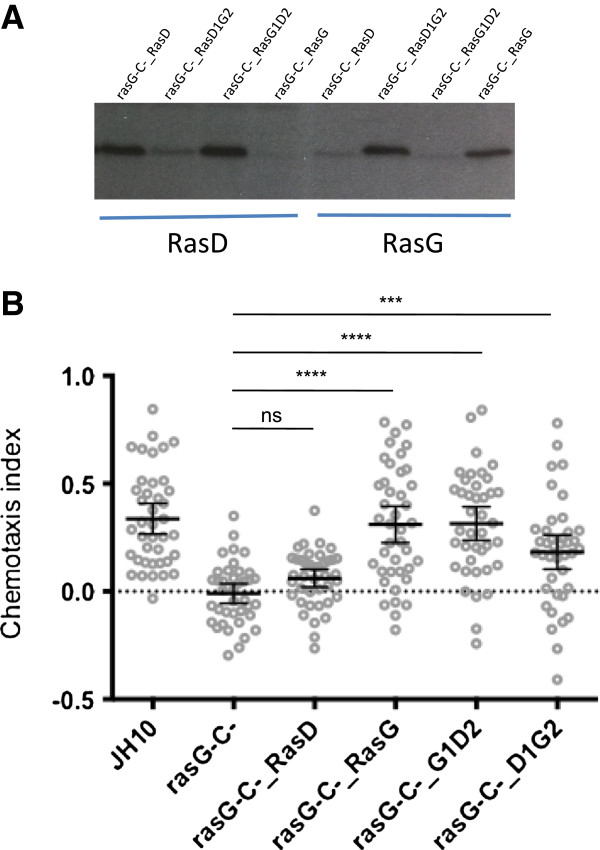
Both N- and C- terminal halves of RasG are required for optimal folate chemotaxis of axenically grown cells. (A) Expression of RasG/RasD protein chimeras detected by binding of RasG and RasD antibodies specific to the C-terminus. (B) Chemotaxis index protein chimeras and controls [n = 40]. Error bars indicate the 95% confidence interval of the mean. Statistical significance: ns = P > 0.05; *** = P < 0.001; **** = P < 0.0001. Light grey circles show average chemotaxis index of each cell. All strains were grown in axenic conditions.